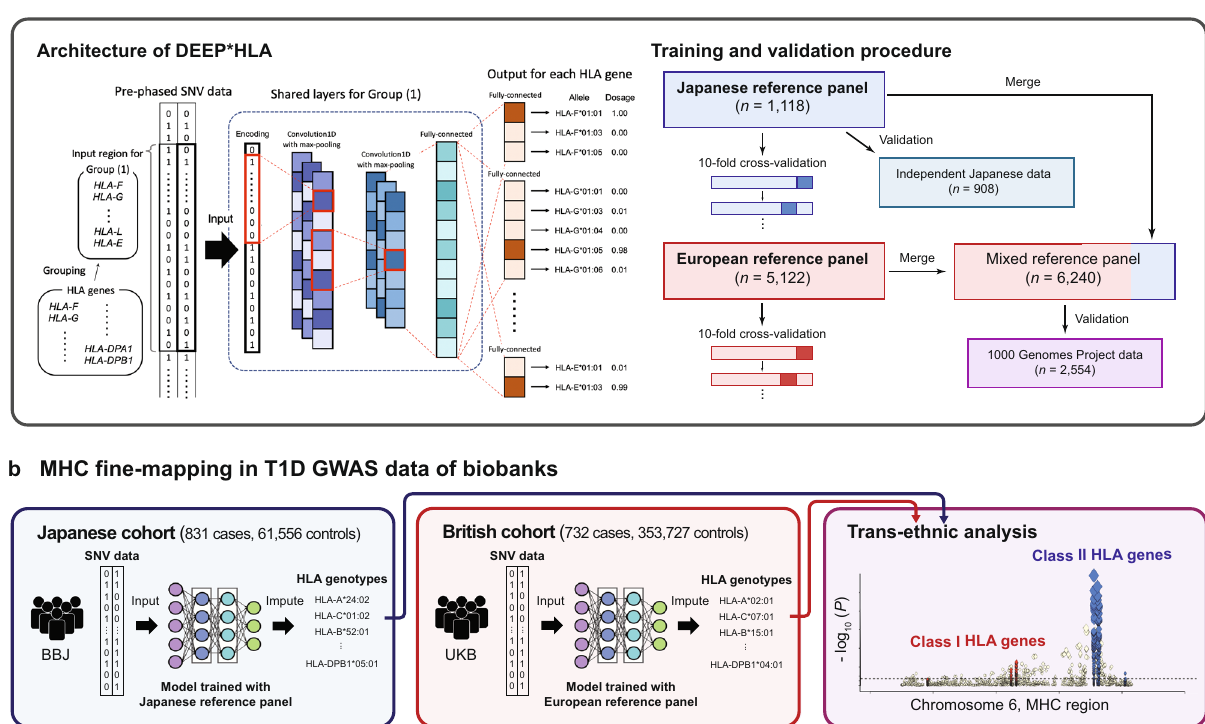
Fig. 1 An overview of the study. a DEEP*HLA is a deep learning architecture that takes an input of pre-phased genotypes of SNVs and outputs the genotype dosages of HLA genes. To train a model and benchmark its performance, we used Japanese and European HLA reference panels respectively. We evaluated its accuracies in cross-validation with other methods. For the Japanese panel, we also evaluated its accuracy by applying the trained model to an independent Japanese HLA dataset. Further, we experimentally generated a mixed panel and validated its accuracy using 1KGv3 data. b We conducted transethnic MHC fi ne-mapping in T1D GWAS data. We performed HLA imputation for the Japanese cohort from BBJ and the British cohort from UKB using models speci fi c for individual populations. We integrated the individual results of imputed genotypes and performed transethnic association analysis. SNV single nucleotide variant, HLA human leukocyte antigen, MHC major histocompatibility